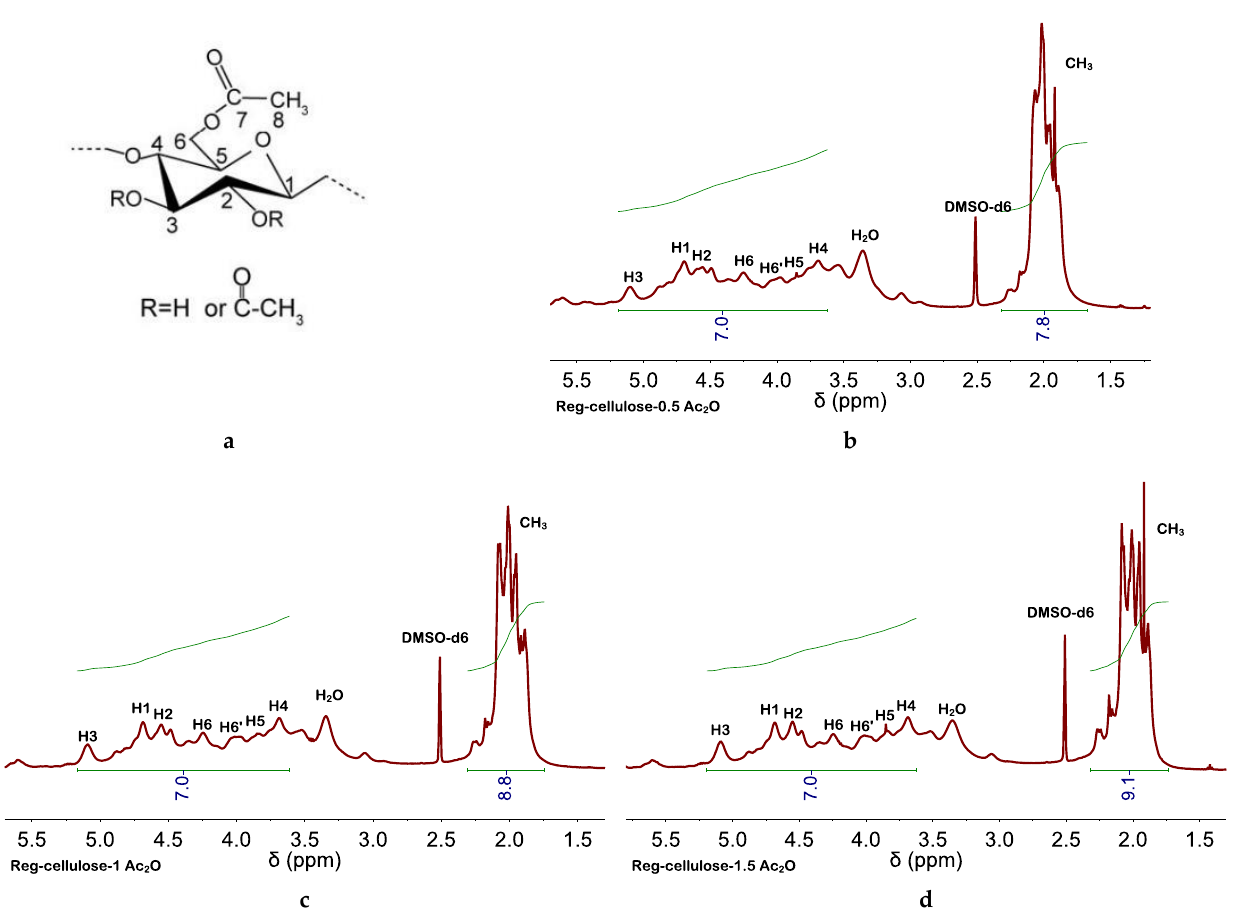
Figure 6. Glucose unit with labelled atoms ( a ) used for the assignment of peaks in the 1 H NMR spectra of cellulose obtained after acetylation at 60 °C in the presence of ( b ) 0.5, ( c ) 1, or ( d ) 1.5 equivalents of Ac 2 O. DSs of ca. 2.5, 2.9, and 3 were obtained from the integrals of peaks assigned to protons of the acetyl group (CH 3 ) and the anhydroglucose unit (AGU) — e.g., 𝐷𝑆 = 7 × 𝐼 (𝐶𝐻 3 × 𝐼 (𝐴𝐺𝑈,𝐻) , where 7 and 3 come from the number of protons in the AGU and the number of hy- droxyl groups per AGU. All 1 H NMR spectra were performed at 25 °C.